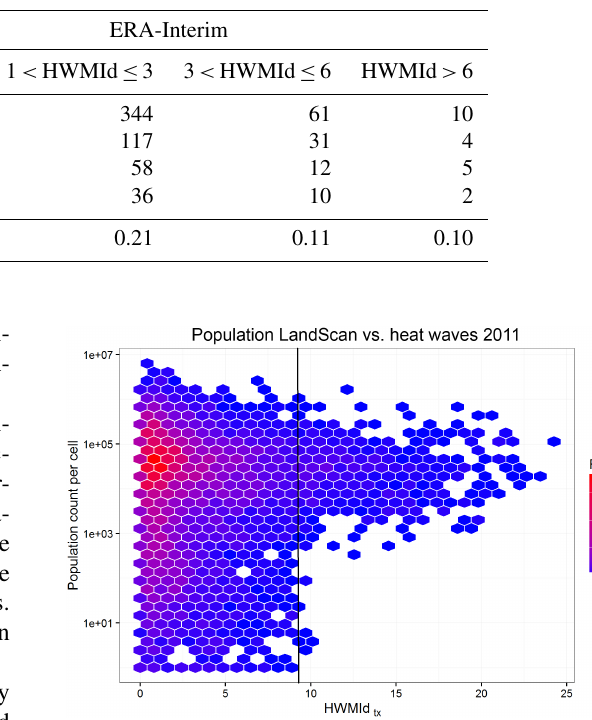
Figure 7. Density plot of population affected by heat waves of max- imum temperature detected by reanalysis in 2011 using the Land- Scan population count database. The y axis refers to the popula- tion count per cell, where the cell is the 0.75 ◦ × 0.75 ◦ ERA-Interim pixel. The black vertical line is at HWMId =